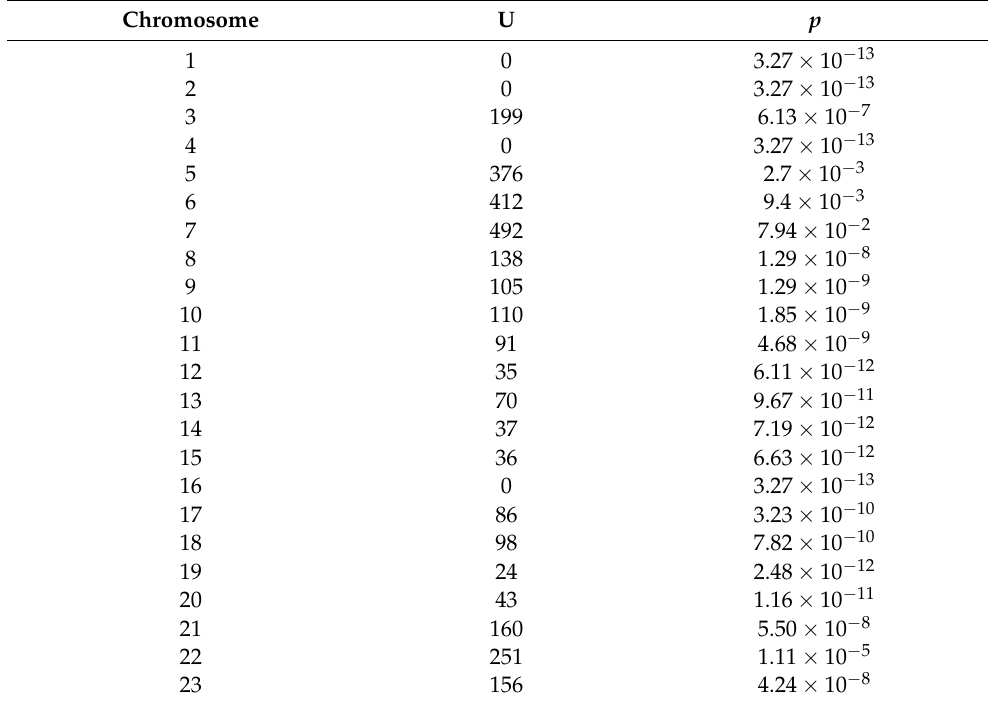
Table 3. Mann–Whitney U Test on 35 independent structures. We carry out the Mann–Whitney U test between the dSCC of the structures generated with p = 0.002 and p = 0.004 given in Figures 12 and 13, respectively. Note that all structures are independently generated; thus, each dSCC or observation is independent.